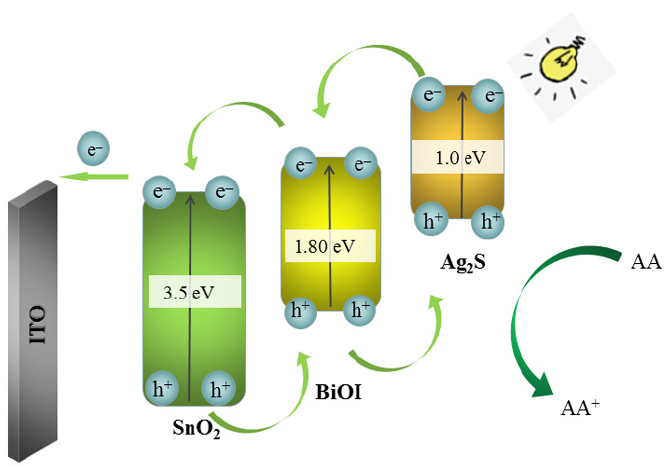
Figure 3. The possible photogenerated electron-hole transfer mechanism of the immunosensor.